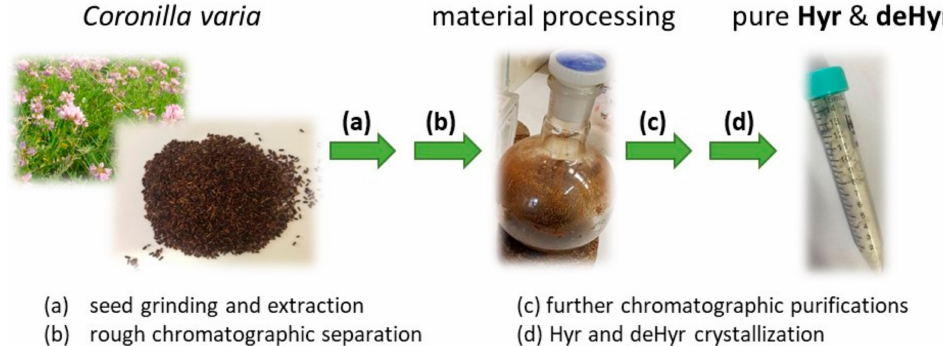
Figure 2. Diagram presenting the process leading to the isolation of Hyr and deHyr from the seeds of Coronilla varia